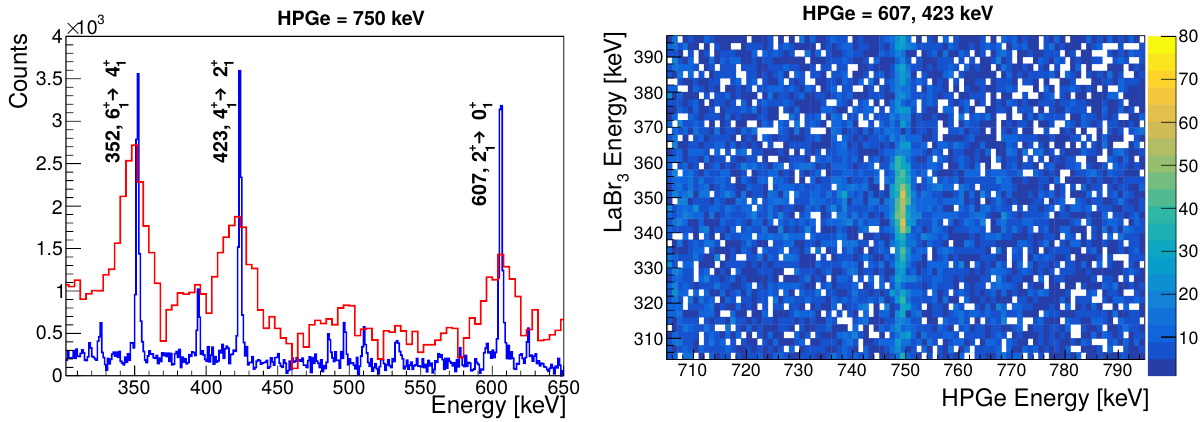
state in 134 Te. 1